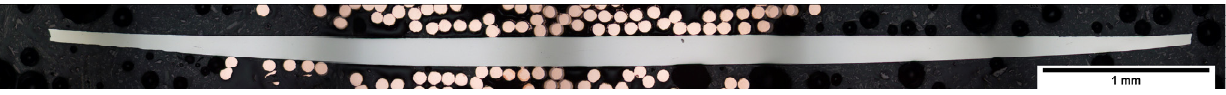
Figure 2. Cross-section of Fe 73.9 Cu 1 Nb 3 Si 15.5 B 6.6 after HPT-deformation at 473 K and 10